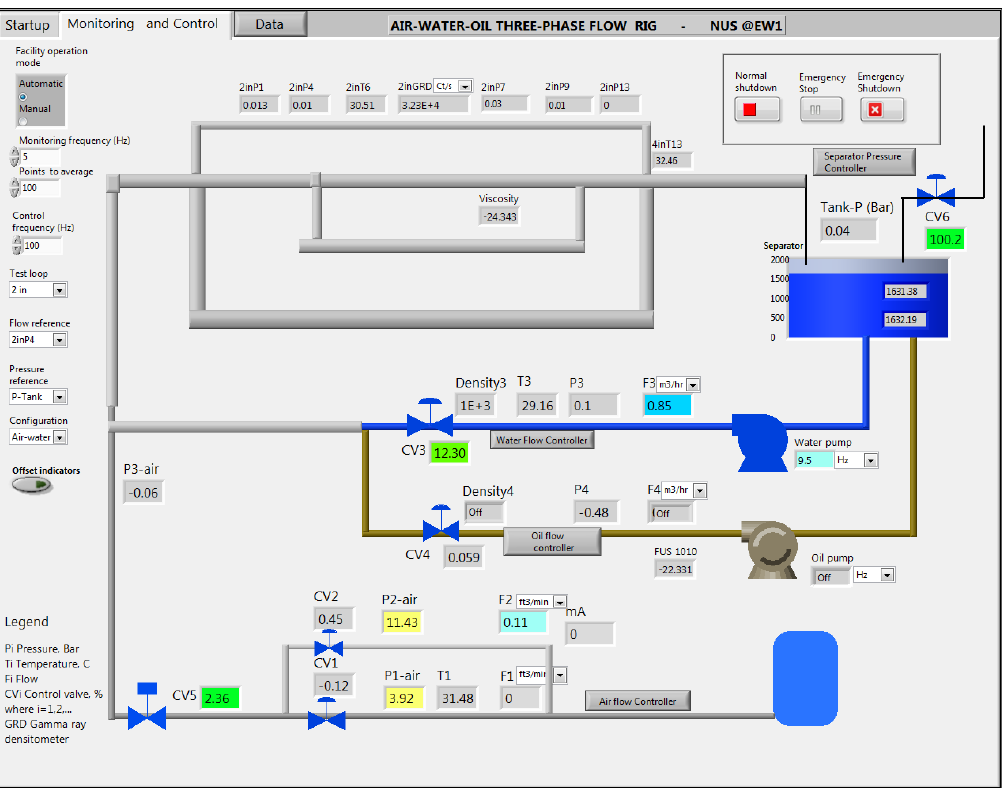
Figure 4. Experimental setup control panel [30] .